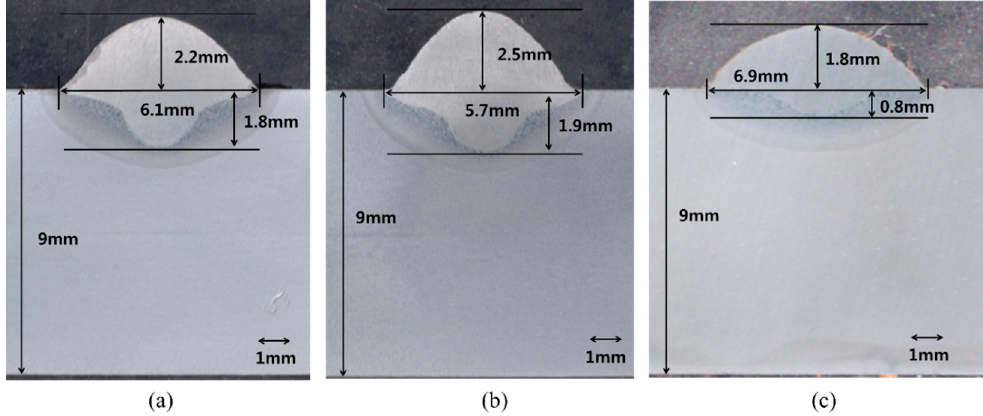
Figure 12. Experiment results of bead profiles: ( a ) flat position; ( b ) overhead position; ( c ) vertical down position. Table 3. Experimental results of bead profiles in various welding positions. Welding position